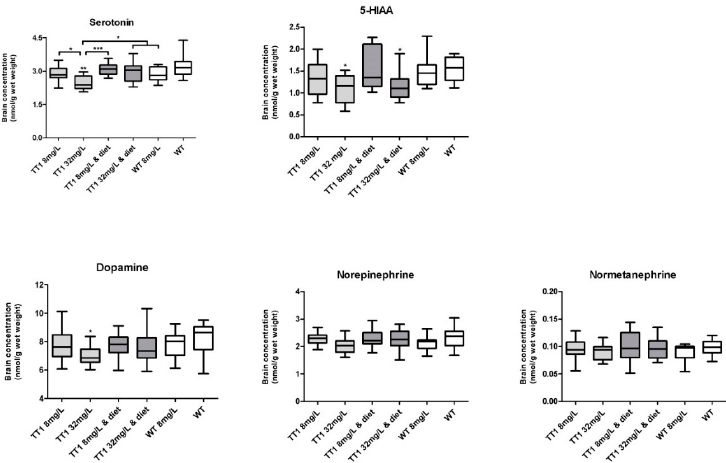
Figure 4. Concentrations of brain neurotransmitters and its metabolites. Numbers of mice are n = 13 or n = 14 for all treatment groups. Untransformed data are expressed as boxplots (min–max whiskers). * p < 0.05, ** p < 0.01 and *** p < 0.001 (two-sided).